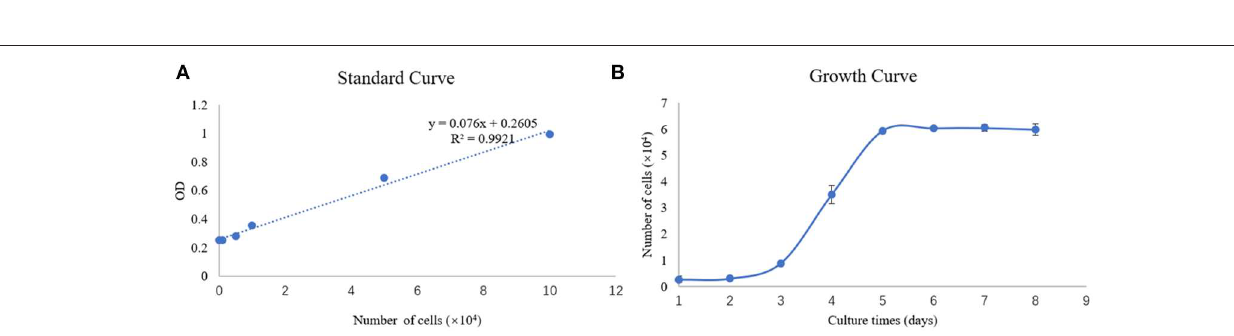
FIGURE 3 | Standard curve and growth curve of SEECs. (A) Standard curve of SEECs. (B) Growth curve of SEECs.